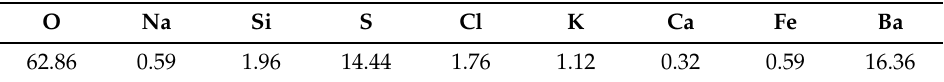
Figure 4. Scanning electron microscopy (SEM) image of the region with fixed barium, magnitude 2000×. Table 3. Energy dispersive X-ray spectroscopy (EDS) analysis of the Ba cluster (atom %).